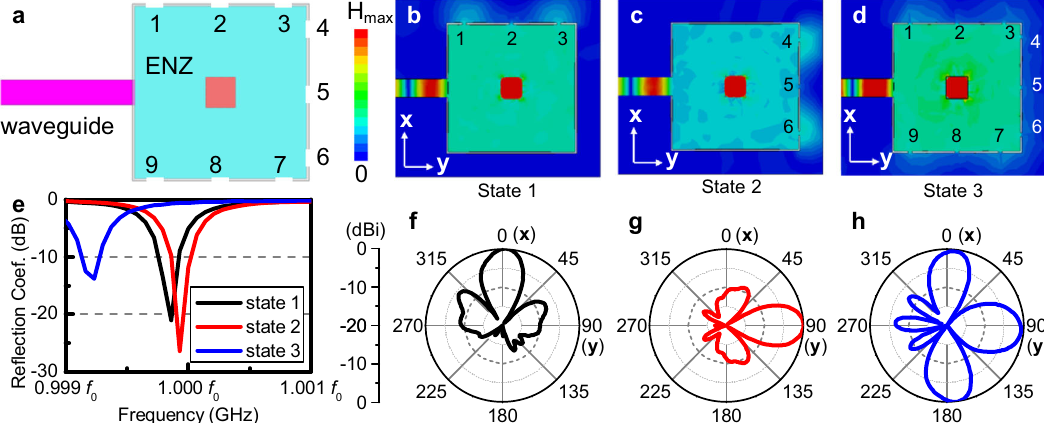
Fig. 4 Antenna with coded radiated beam capabilities. a Sketch of the structure of a fl exible ENZ antenna with coded radiated beam capabilities. State 1 is formed when slot 1,2, and 3 are turned “ ON ” , which corresponds to the code “ 111000000 ” . State 2 and State 3 correspond to codes “ 000111000 ” and “ 111111111 ” , respectively. b – d Colormap of the magnitude of the magnetic fi elds at the central plane of State 1 – 3. e The simulation results for re fl ection coef fi cients. f – h The normalized angular distributions of the radiated power in the